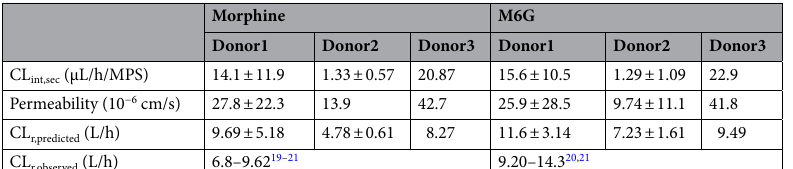
Table 1. The summary of VPT-MPS derived intrinsic secretion clearance and permeability value for morphine and M6G, with predicted renal clearance of morphine and M6G using mechanistic kidney model with VPT-MPS